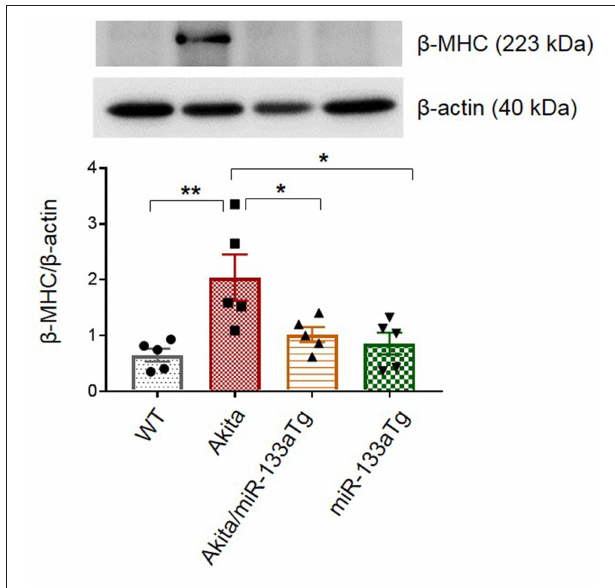
FIGURE 5 | Overexpressed miR-133a blunts expression of β -MHC. Representative Western blot showing expression of beta-MHC and its densitometry analysis in the left ventricle of WT, Akita, Akita/miR-133aTg, and miR-133aTg mice. Values are presented as mean ± SEM. One-way analysis of variance (ANOVA) and Tukey’s test were used. N = 5 per group. * P < 0.05; ** P <